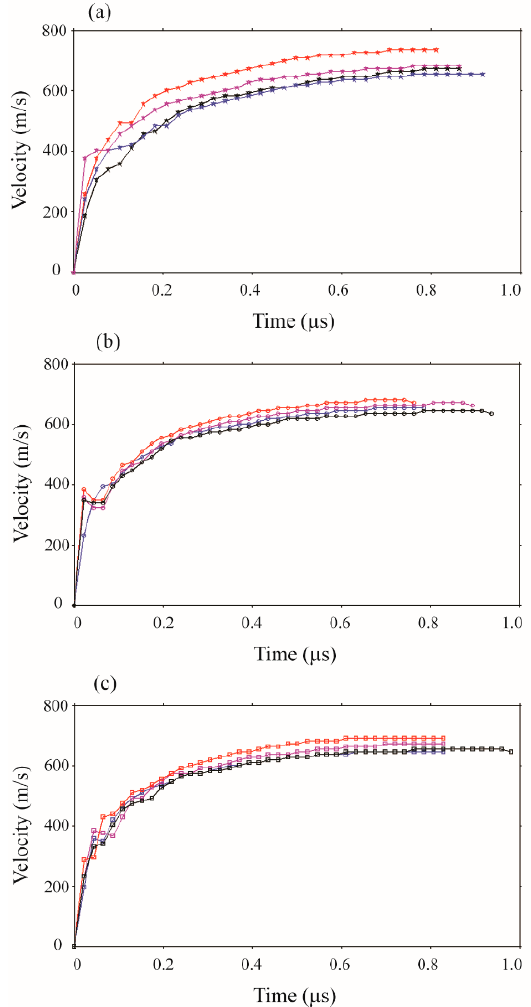
Figure 6. Flyer Velocity for flyers with dimensions of ( a ) 12 mm × 12 mm, ( b ) 7 mm × 7 mm, ( c ) 4 mm × 4 mm ( E = 3.1 J, D = 4 mm, t = 75 μ m , L = 525 μ m).